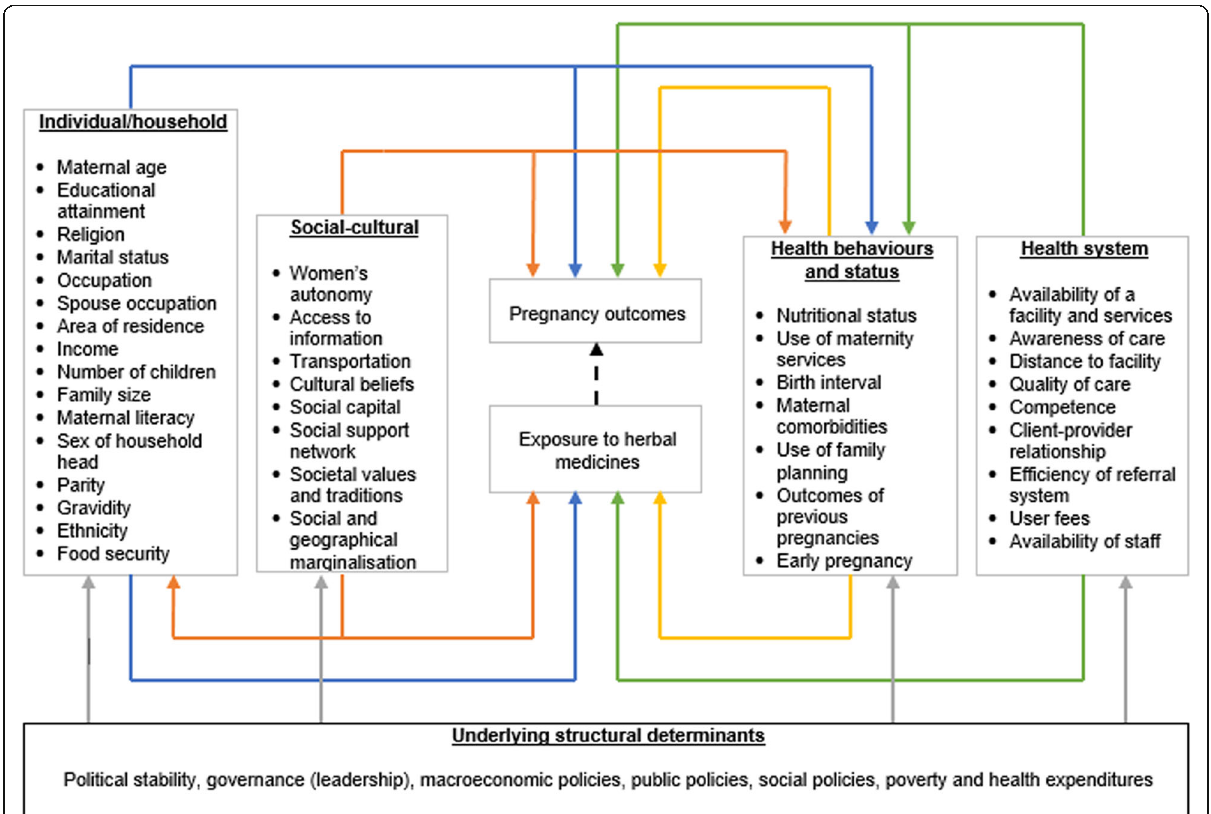
Fig. 1 Hypothetical determinants of pregnancy outcomes and the use of herbal medicines among pregnant women. The relationship between exposure to herbal medicines and pregnancy outcomes is not clearly understood, hence, the broken